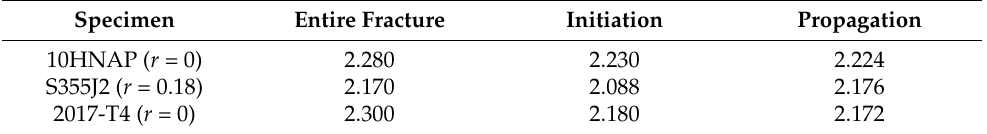
Table 2. Exemplary fractures fractal dimension Df results for entire fracture and areas of crack ini- tiation and propagation of three analysed types of specimens.